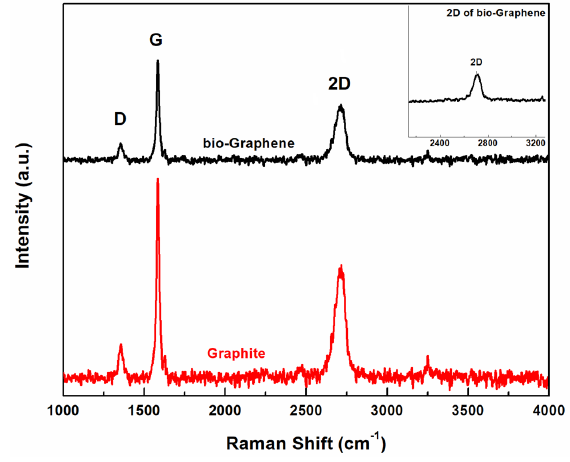
Figure 5. Raman spectra of graphite and bio-Graphene.